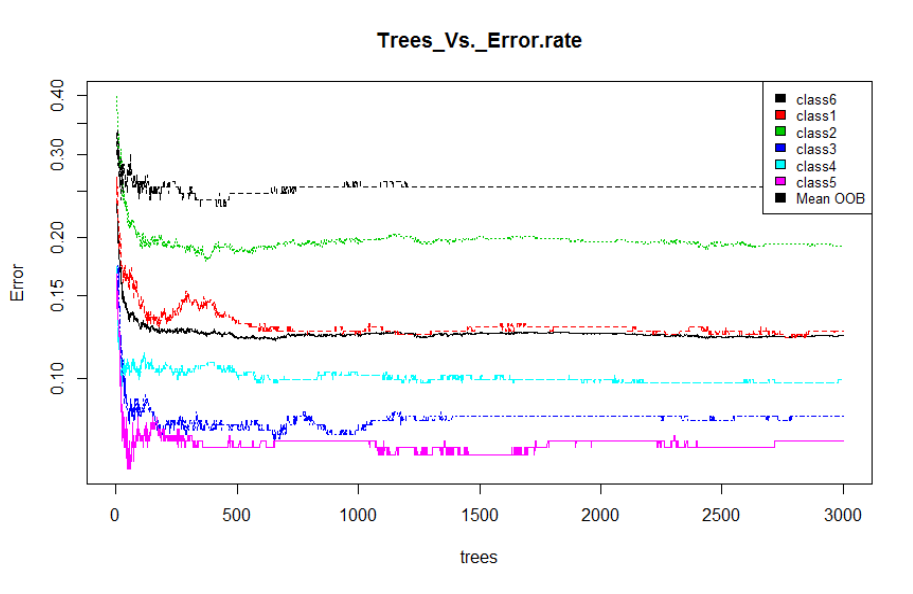
Figure 4. Number of trees vs. Error rate